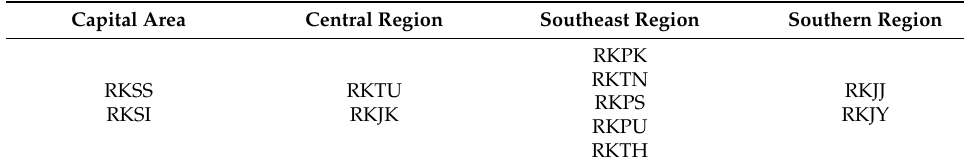
Table 6. Air Control Zones and its Corresponding Airports.